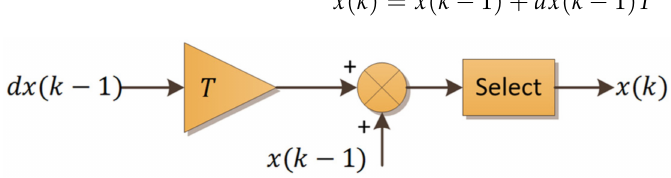
Figure 16. Block diagram for implement the PLL